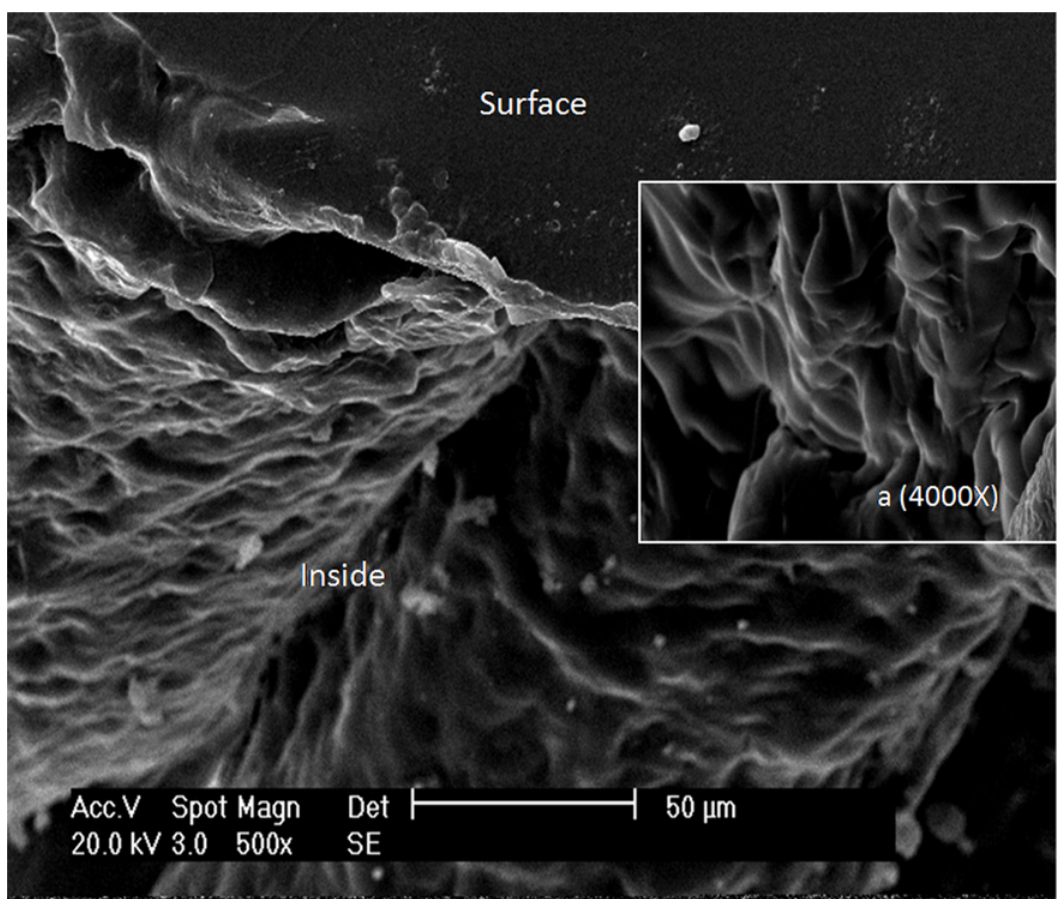
Fig 1. Scanning electron microscopy images of the P(NIPAm- co -BMA) hydrogel (×500). P(NIPAm- co -BMA) is poly (N-isopropyl acrylamide- co - butylmethacrylate); ‘ Surface ’ and ‘ Inside ’ indicates the surface and inside of P(NIPAm- co -BMA) hydrogel, respectively. a , the inside of P(NIPAm- co -BMA) hydrogel ( ×